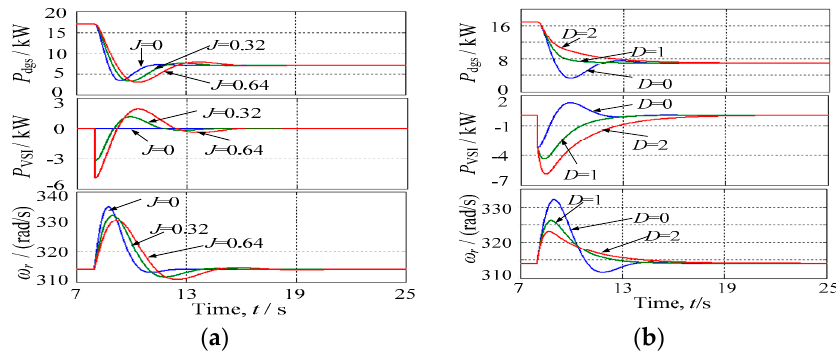
Figure 5. Effects of the inertia and damping on an active power transient. ( a ) Different values of virtual inertia and D = 0; ( b ) Different values of virtual damping and J = 0.32 kg·m 2 .